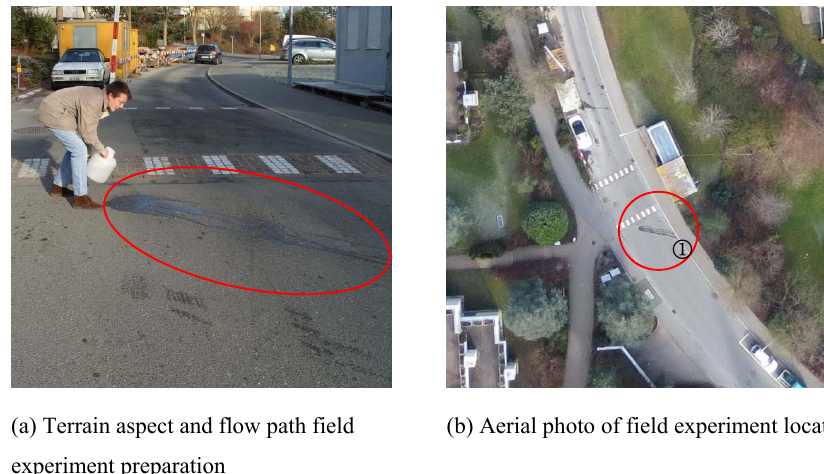
Figure 1. Example of the field experiments conducted to calculate the terrain flow direction and flow path delineation